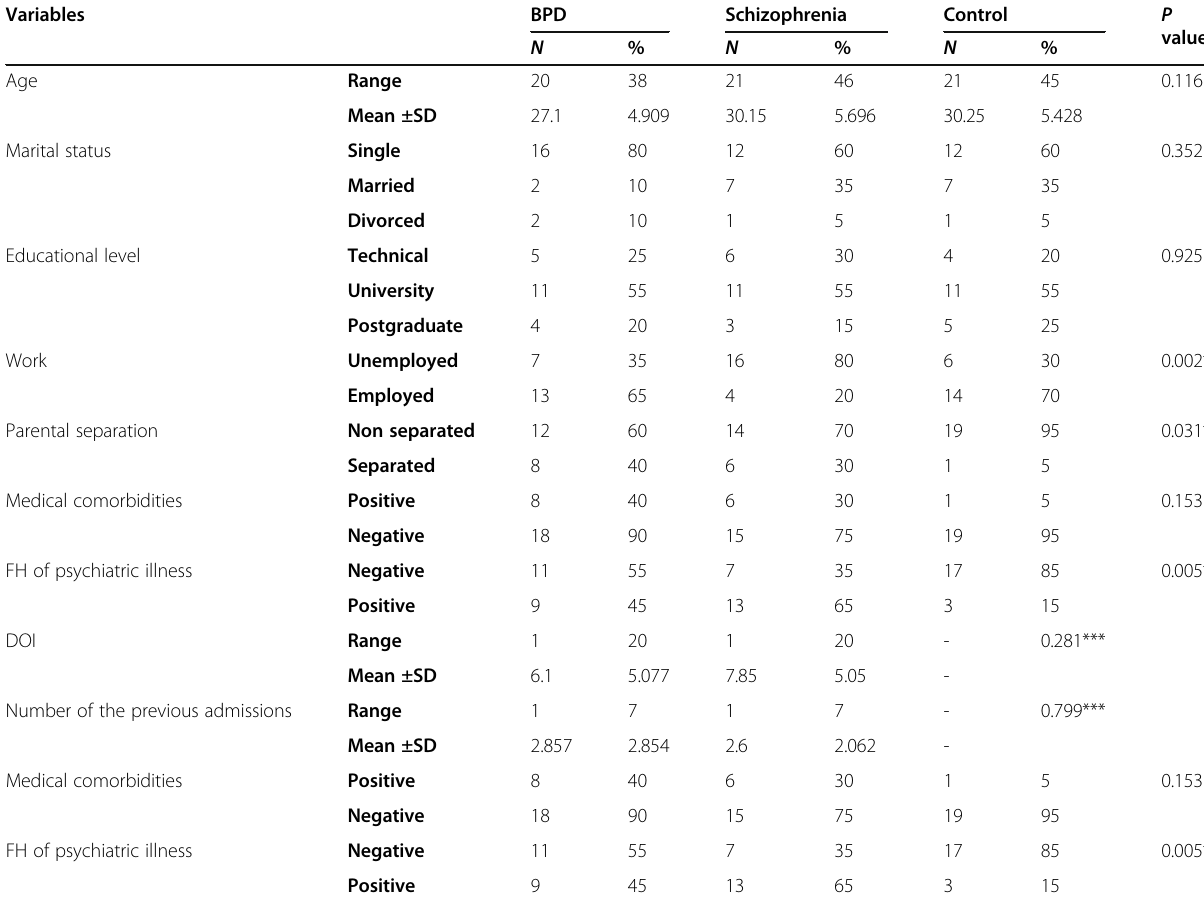
Table 1 Sociodemographic and clinical data of the studied groups. Variables BPD